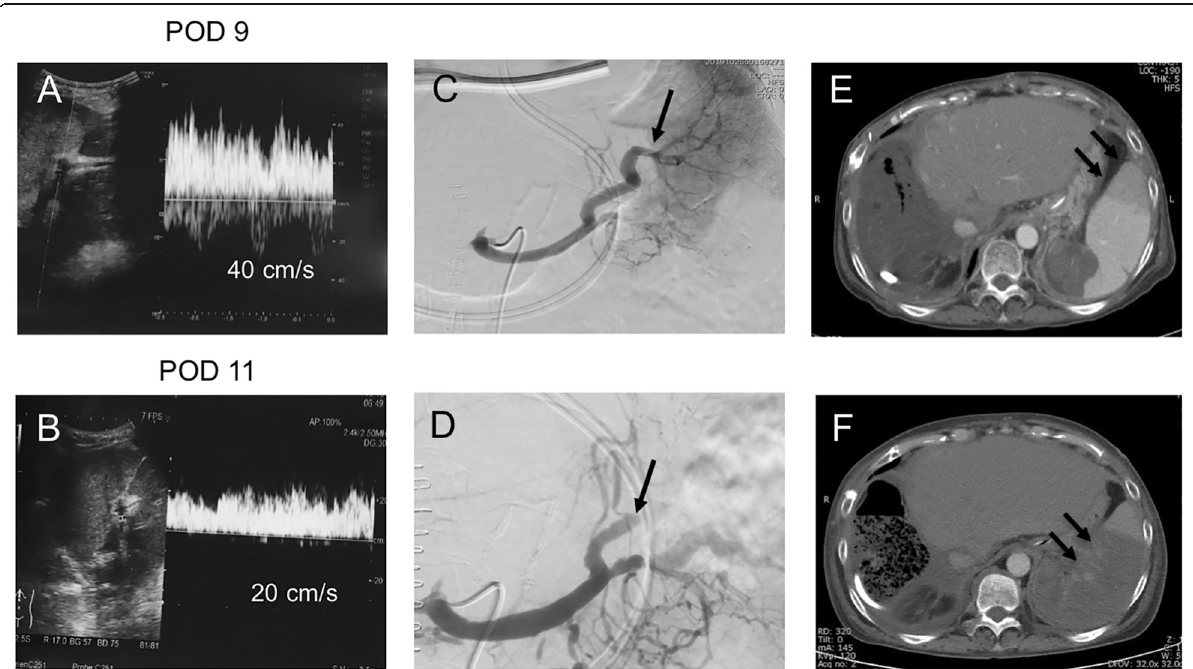
Fig. 1 Postoperative assessment of portal flow and dynamic CT image before ( a , c , e ) and after ( b , d , f ) splenic artery embolization. a Portal flow at the umbilical portion on postoperative day (POD) 9. b Portal flow on POD 11 at the same branch of the portal vein, which had decreased to half of that on POD 9. c Splenic arterial overflow with splenomegaly showed enhanced flow on injection of the contrast. Arrow, the main branch of the splenic artery. d The main branch of the splenic artery was completely occluded by trans-catheter coil embolization on POD 10. Arrow, the main branch of the splenic artery. e Dynamic computed tomography (CT) before splenic artery embolization showed only the upper pole of the spleen turns pale by the ligation. Arrow, paled lesion of the spleen. The lower pole has lost the arterial flow due to previous partial splenic artery embolization. f Dynamic CT after splenic artery embolization showed most of the spleen lost the arterial flow. Arrow, paled lesion of the spleen. POD, postoperative day; CT, computed tomography